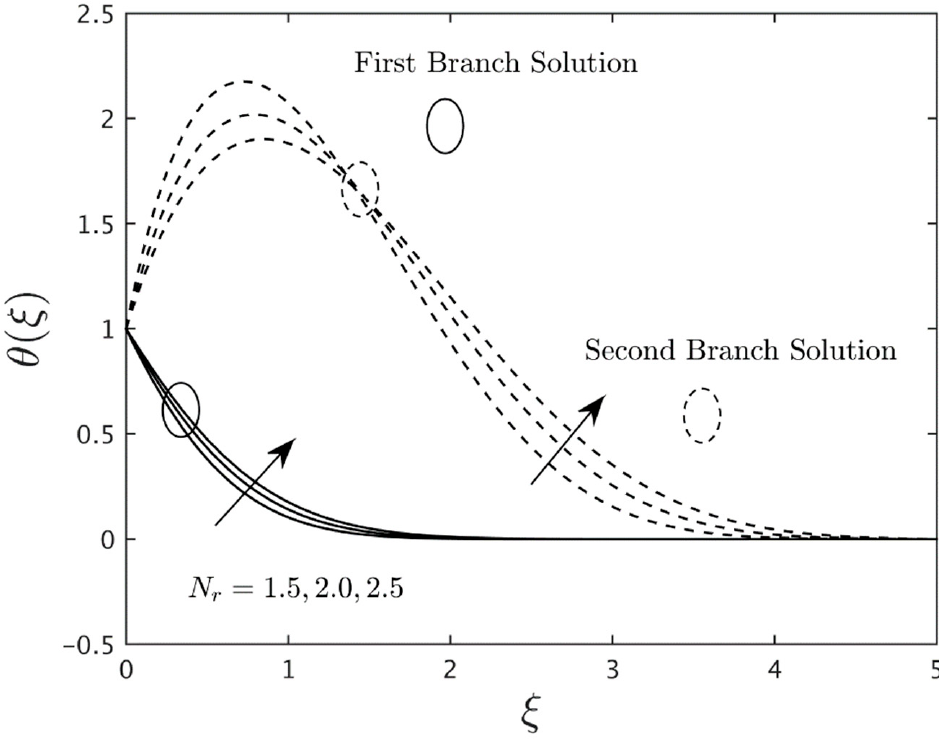
Figure 14. Temperature profile for the several values of N r .